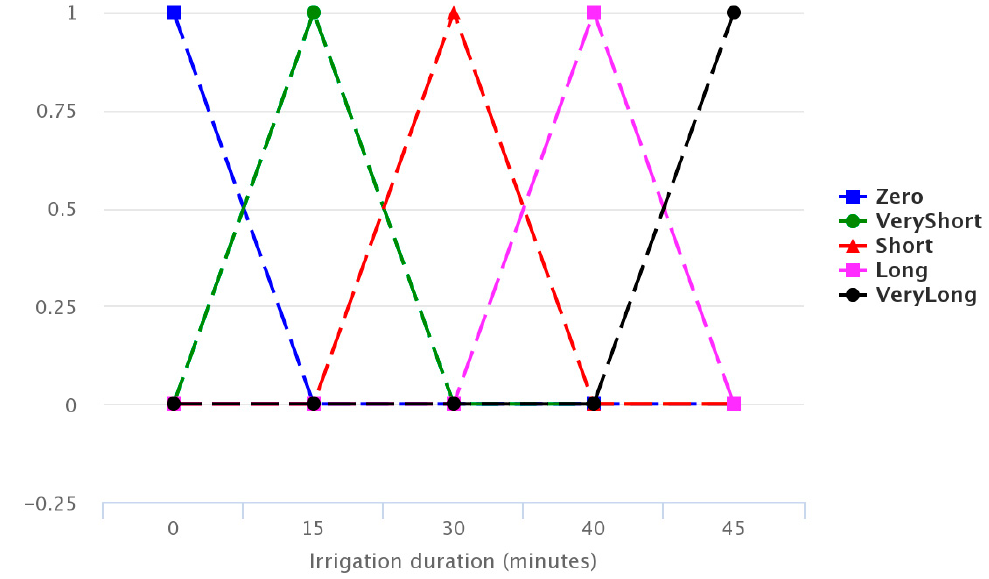
Figure 11. Irrigation time estimate.